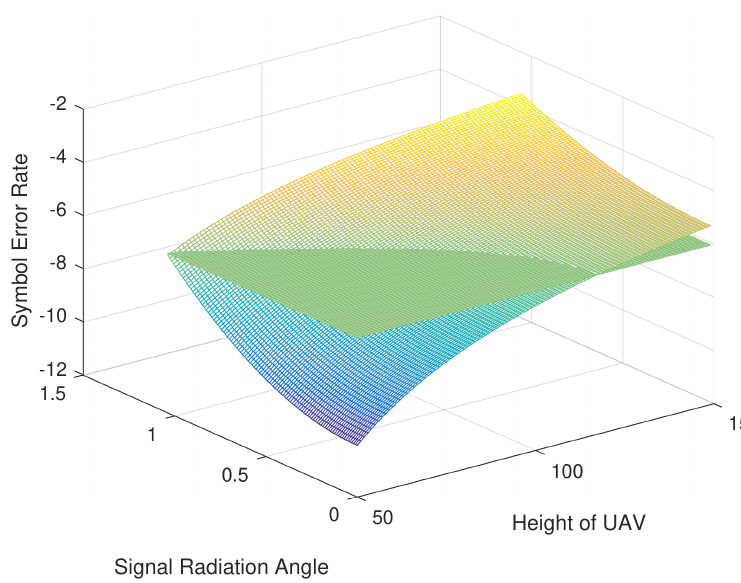
Figure 6. Symbol error rate of the USER versus α and H UAV